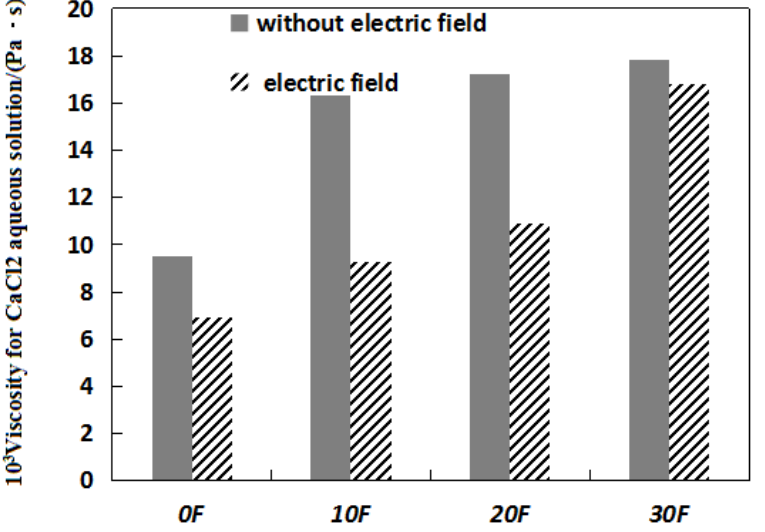
Figure 2. The 10 3 average viscosity with no Fe 2+ ions added ( 0F ) and 10 Fe 2+ added ( 10F ), 20 Fe 2+ added ( 20F ), and 30 Fe 2+ added ( 30F) with and without EF and EF.